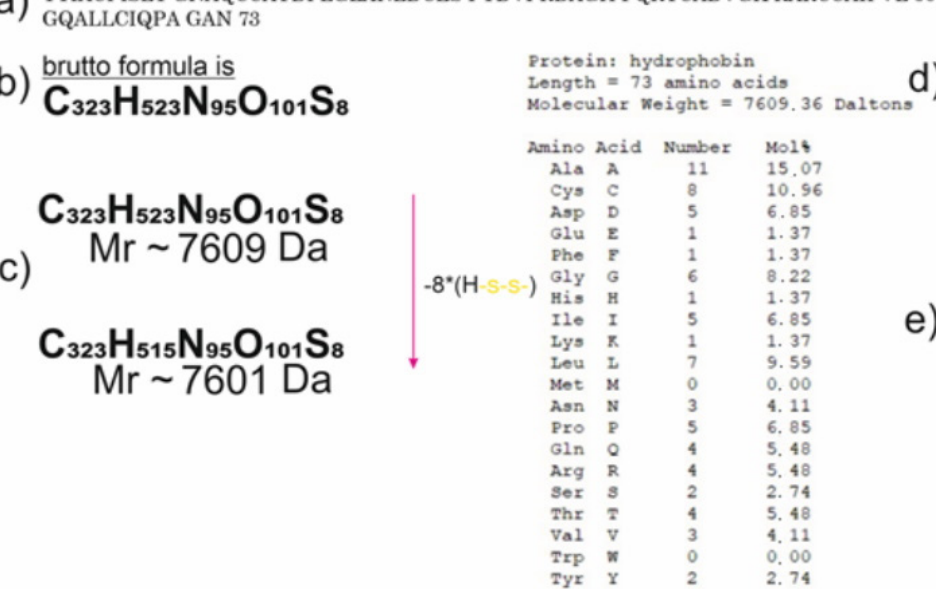
Figure 2. Physicochemical properties of the hydrophobin. ( a ) The sequence of the hydrophobin, annotated under the result of the full-genome sequencing of the ex-type strain of Sodiomyces alkalinus , F11. ( b ) Atom composition of the goal protein, impressed in numbers of corresponding atoms. ( c ) Chemical transition in mass and atom composition due to all of the disulfide bonds forming. ( d ) Information about the exact mass of the protein. ( e ) The amino acid composition of the hydrophobin.